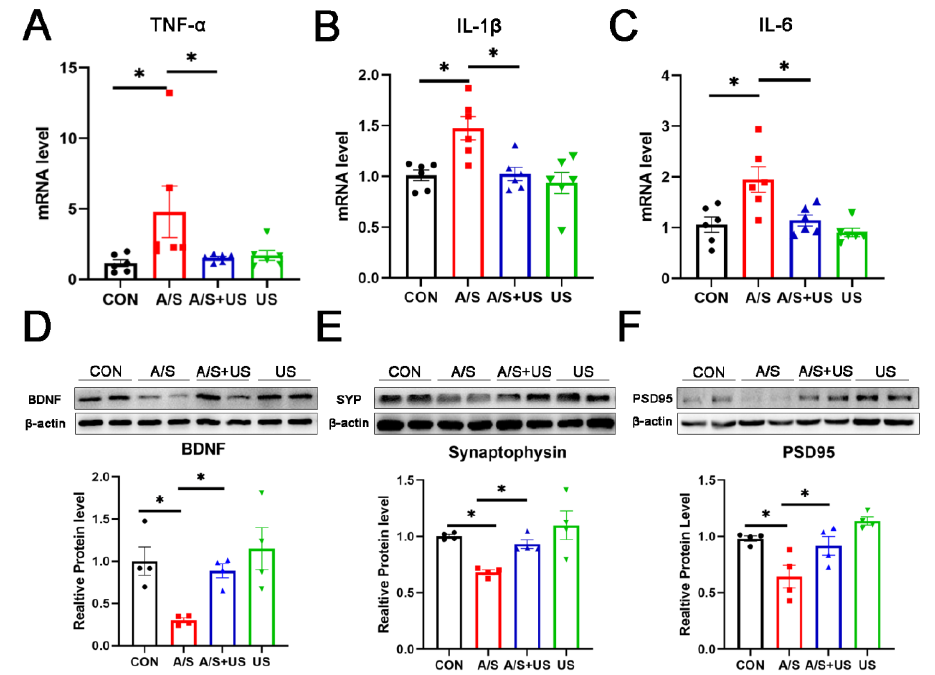
Figure 4. LIPUS attenuates neuroinflammation and synaptic dysfunction of the hippocampus after anesthesia/surgery in aged mice. The mRNA level of inflammatory cytokines of TNF- α ( A ), IL-1 β ( B ), and IL-6 ( C ) in the hippocampus among the four groups ( n = 6 per group). Western blotting analysis of the synapse-related proteins BDNF ( D ), Synaptophysin ( E ), and PSD95 ( F ) in the hippocampus among the four groups ( n = 4 per group). Data were presented as Mean ± SEM. One-way ANOVA followed by Bonferroni’s multiple comparisons test. * p < 0.05.